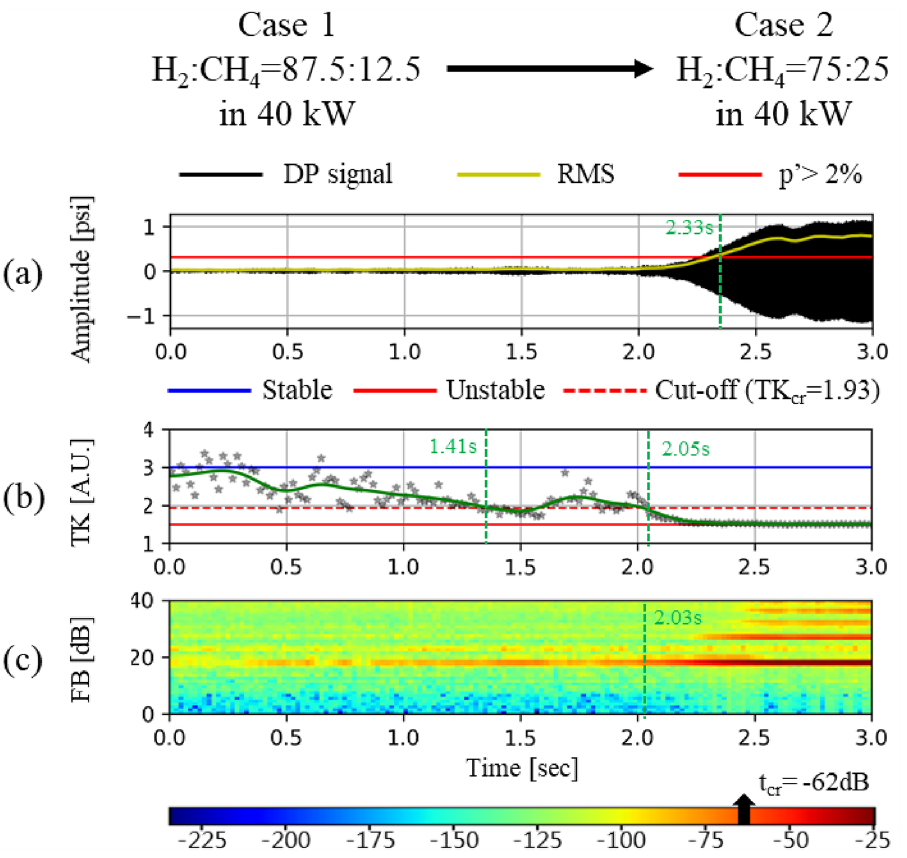
Figure 9. CI analysis results using ( a ) RMS, ( b ) TK, and ( c ) FB for transition from Case 1 to Case